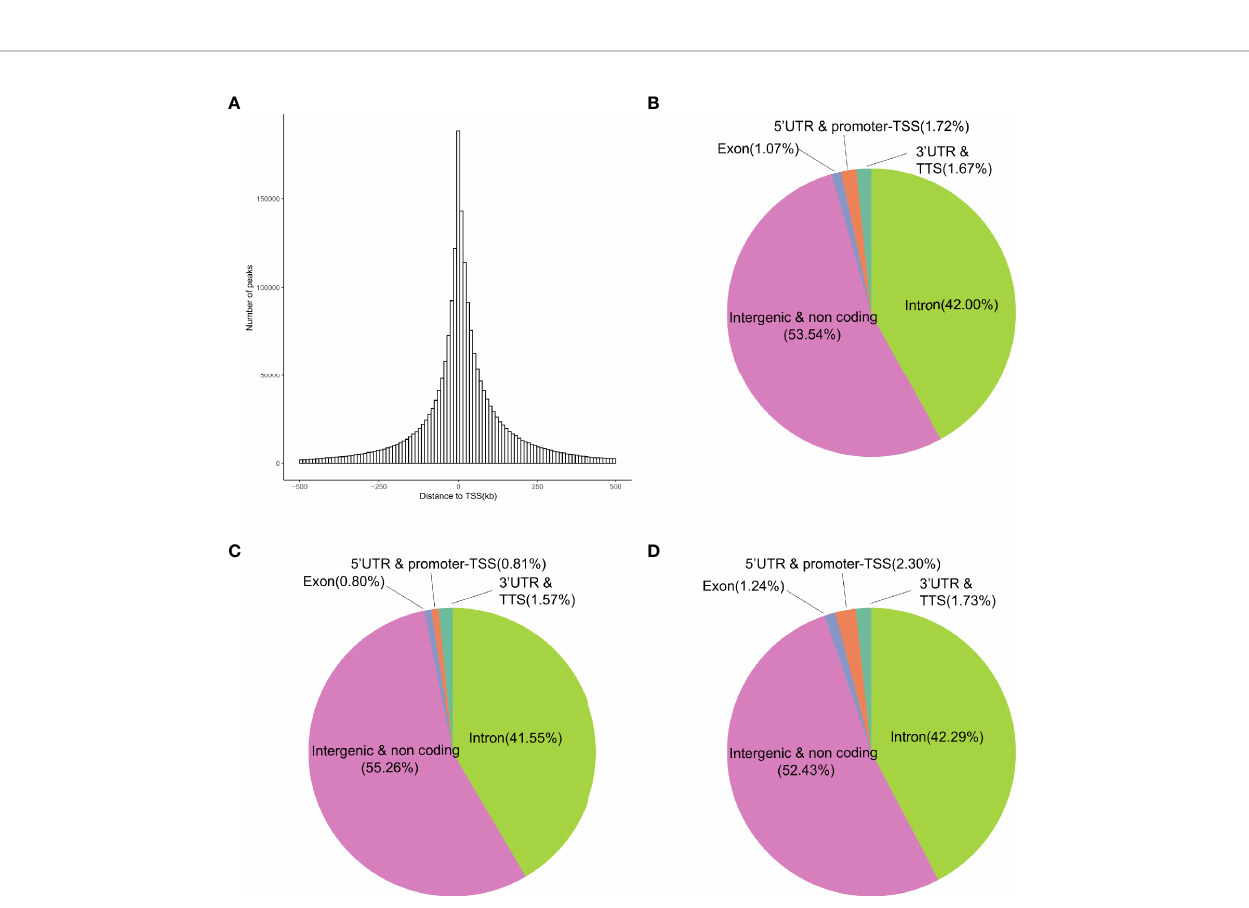
FIGURE 3 | Genomic annotation of open chromatin peaks in the ES and LS samples. (A) Distribution of the distances of peaks to the TSS of the nearest genes. (B – D) Pie charts showing the distribution of peaks in different genomic regions in all 17 samples (B) , the ES group (C) and the LS group (D)